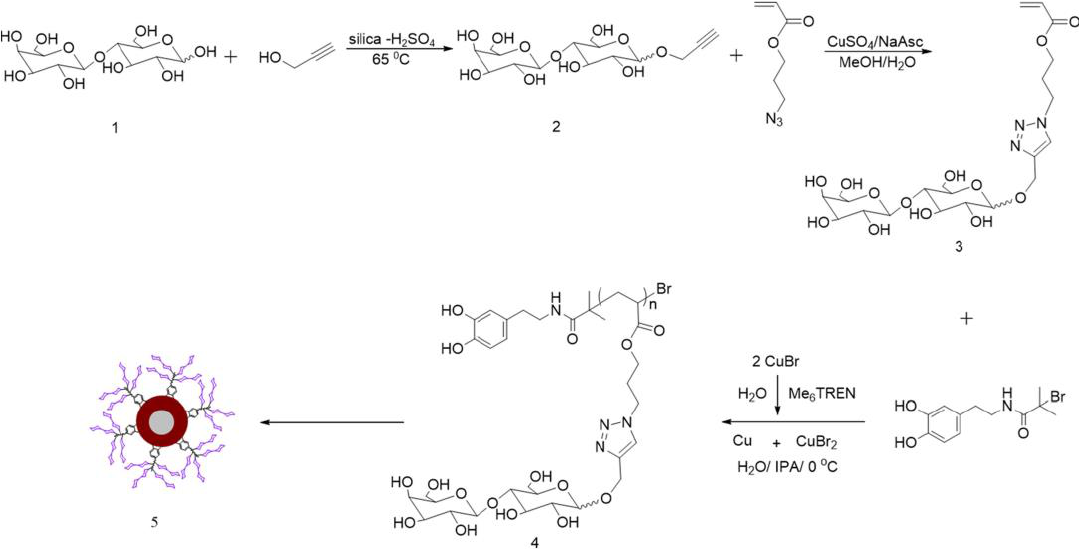
Figure 6. Synthetic route of Fe 3 O 4 @TiO 2 @poly(LacA) hybrid nanoparticles. Figure reproduced from ref. [33] with